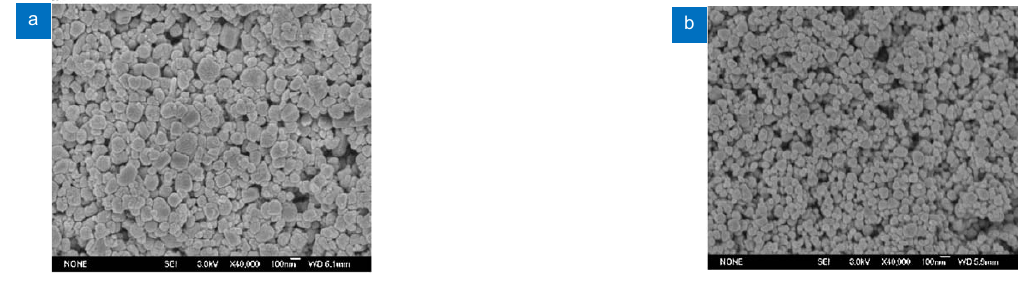
Fig. 13 | SEM image of the ZnO nanoparticles fabricated by (a) doctor-blade method and (b) large scale ZnO film prepared by elec- trospray technique after heat treated at 460 °C for 1 h 104